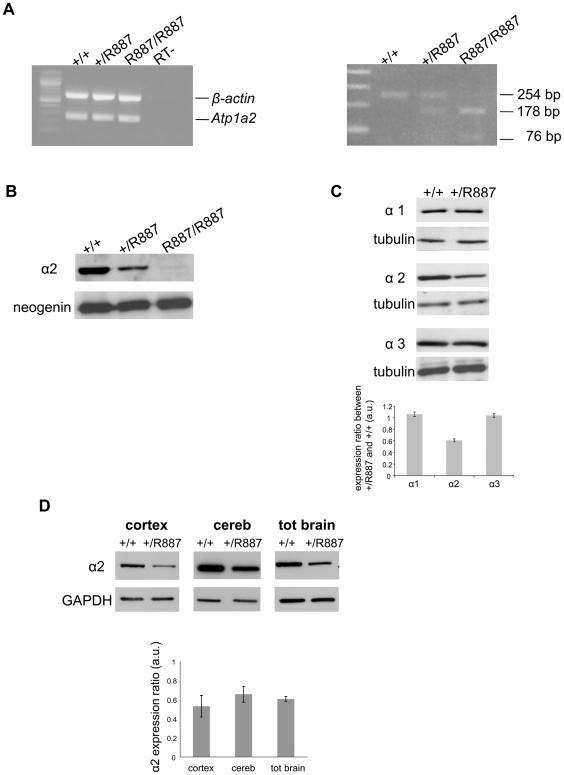
In vivo expression of mutant Atp1a2.Total RNA and protein samples were isolated from brain of wild type (+/+), Atp1a2+/R887 (+/R887) and homozygous Atp1a2R887/R887 (R887/R887) mice at E19.5. A. Left panel. Semi quantitative Atp1a2 RT-PCR (254 bp fragment) on brain cDNA. The b-actin fragment (610 bp) is included as in-tube normalizer. Right panel, same Atp1a2 RT-PCR fragments digested by MspI. B. Protein blot of microsomal fraction probed with anti-α2 Na,K-ATPase antibody and anti-neogenin as loading control; the α2 Na,K-ATPase and neogenin bands appear at the expected size of 110 kDa and 52 kDa, respectively. C. Total brain lysates from adult wild type and Atp1a2+/R887 mice probed with anti-α1, α2, and α3 Na,K-ATPase antibodies; anti- tubulin as loading control. Densitometric quantization shows a 50% reduction of the heterozygous mutant α2 level compared to wild type. Error bars represent ± SD; Student's t test p<0.05, n = 3; α1, α2, and α3 Na,K-ATPases migrate as single bands according to the expected size of 110 kDa. D. Region specific immunoblot from cortex, cerebellum and total brain of adult wild type and Atp1a2+/R887 mice probed with anti-α2 and anti- glyceraldehyde-3-phosphate dehydrogenase (GAPDH) as loading control (Figure 2D). Densitometry evaluation shows significant reduction in α2 level (p<0.05) of 50%, 35% and 40% in cortex, cerebellum and total brain, respectively. Error bars represent ± SD; Student's t test p<0.05, n = 3.